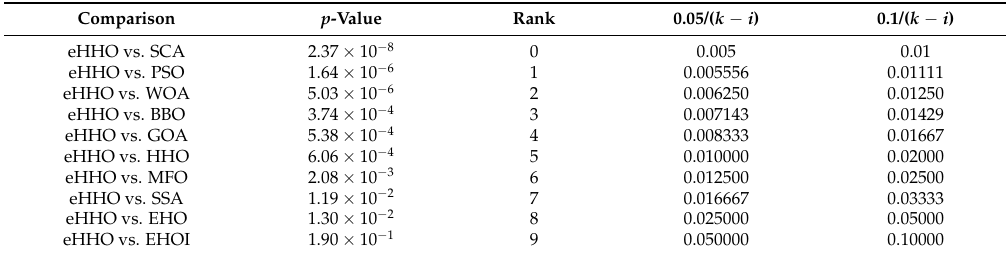
Table 5. Results of the Holm’s step-down procedure.